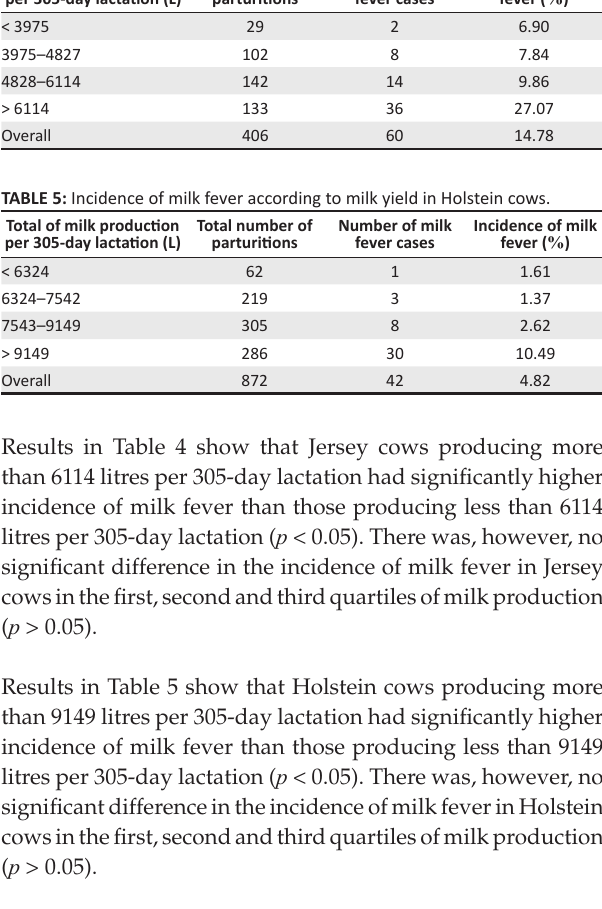
The difference in the amount of UV radiation (Damgaard 1975), average evaporation rate and the difference between maximum and minimum ambient temperature (Capper & Cady 2012; Roche & Berry 2006) in Zimbabwe and other